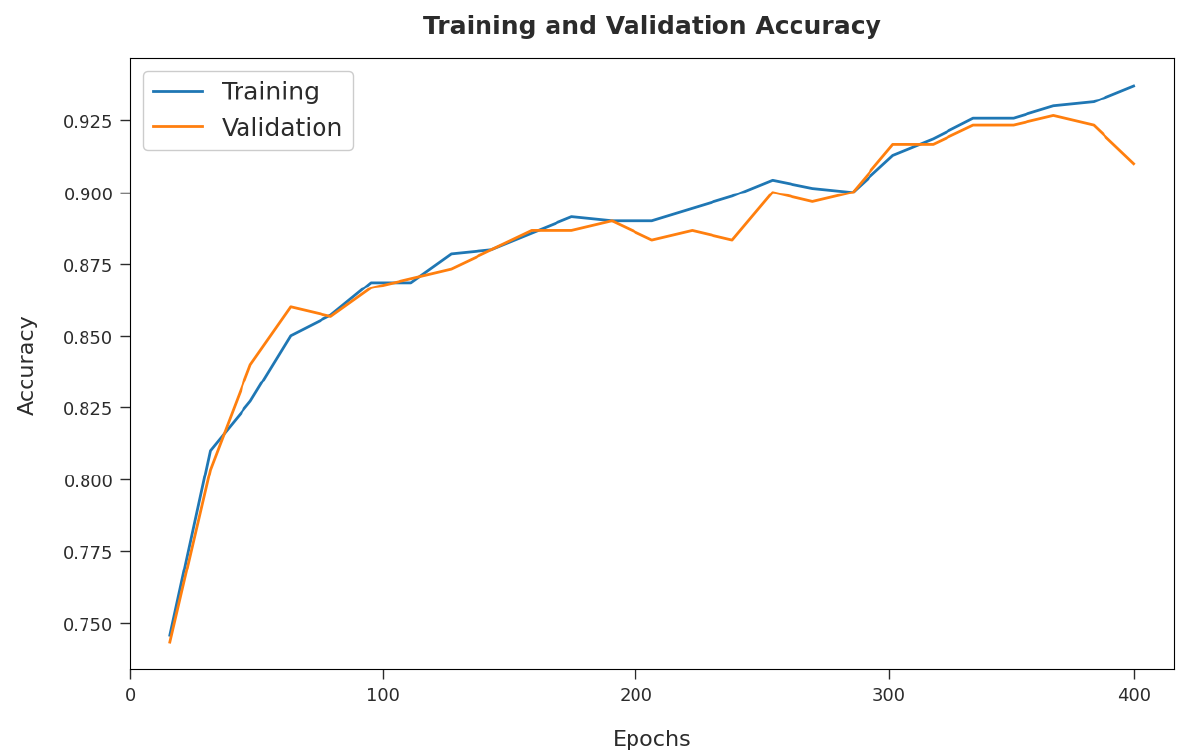
Figure 7. TA and VA analysis of MDTL-ICDDC technique.